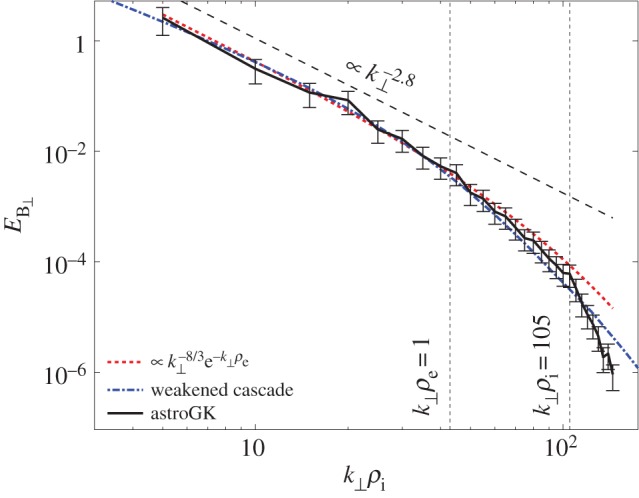
Results of a gyrokinetic simulation with βi=βe. 1D magnetic energy spectra as functions of perpendicular wavenumber. The solid black line represents results from the simulation; the dashed-dotted and dotted lines represent two model predictions and the dashed line represents a fixed spectral index of −2.8. (Adapted with permission from [49].) (Online version in colour.)